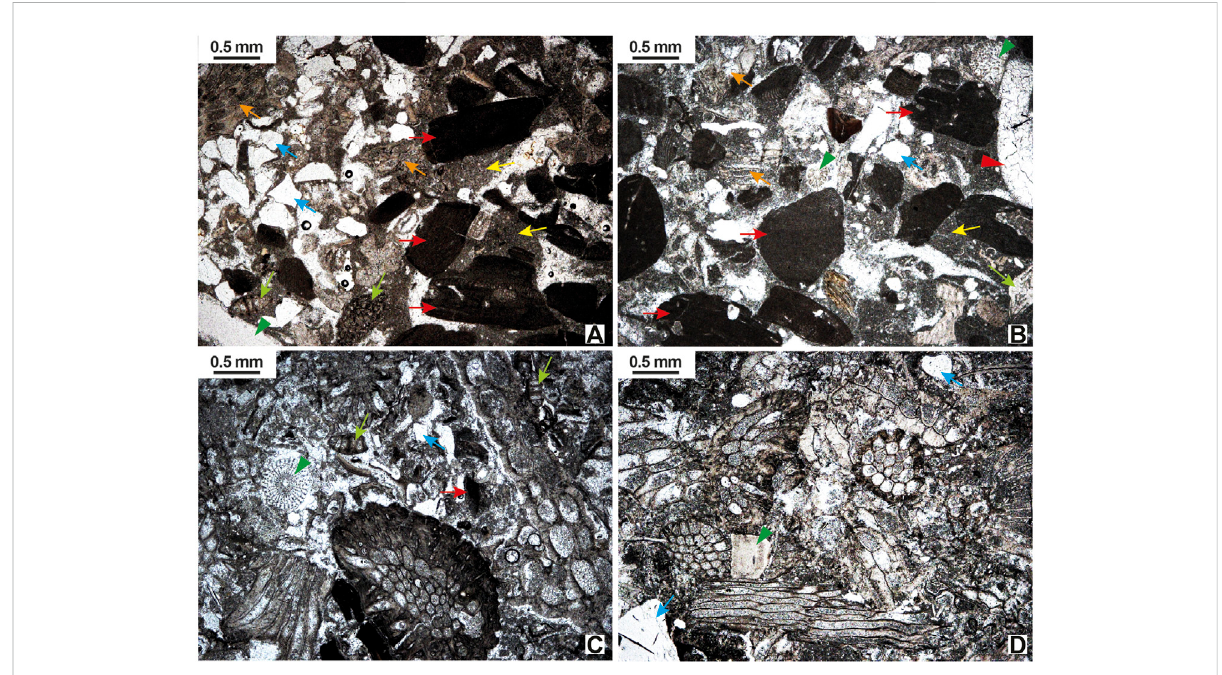
FIGURE 5 Micrographs ofselectedlithofaciesintheAcinipo limestone. (A) Troughcross-beddedpackstone torudstone. Corallinealgalfragmentsarethe main components, followed by bryozoans (orange arrows). Benthic foraminifers (green arrows) and echinoids (green arrowheads) are secondary components. Quartz grains (blue arrows) are locally abundant. The matrix is commonly mudstone (yellow arrows). (B) Large-scale planar cross- bedded coralline rudstone. Coralline algae (red arrows), bryozoans (orange arrows), echinoids (green arrowheads), benthic foraminifers (green arrows), and terrigenous grains, mainly quartz (blue arrows) are the common components. Molds of aragonitic bivalves are fi lled with sparry calcite (redarrowhead).Thematrixisamudstonetowackestone(yellowarrow). (C) Large-scaleplanarcross-beddedbryozoanrudstone.Bryozoansarethe main components with minor coralline algae (red arrows), echinoids (green arrowheads), benthic foraminifers (green arrows), and quartz (blue arrows). (D) Flat-bedded bryozoan packstone to rudstone. The rock is made of bryozoan fragments with echinoids (green arrowheads), benthic foraminifers (green arrows), terrigenous grains (blue arrows), and other bioclasts as very minor